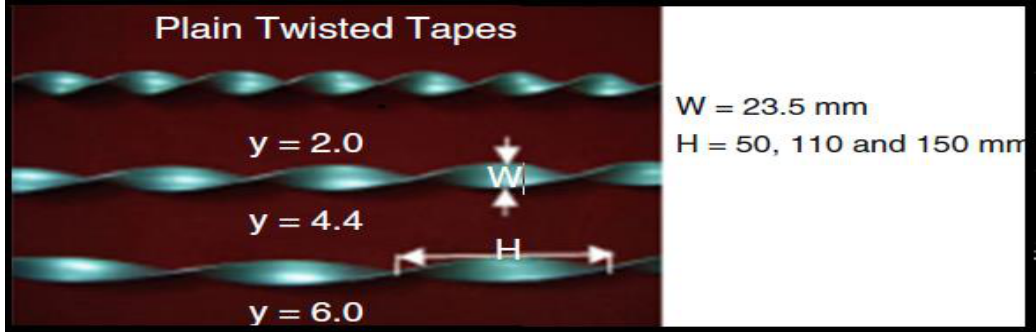
Figure 1: Twisted tape inserts [9].